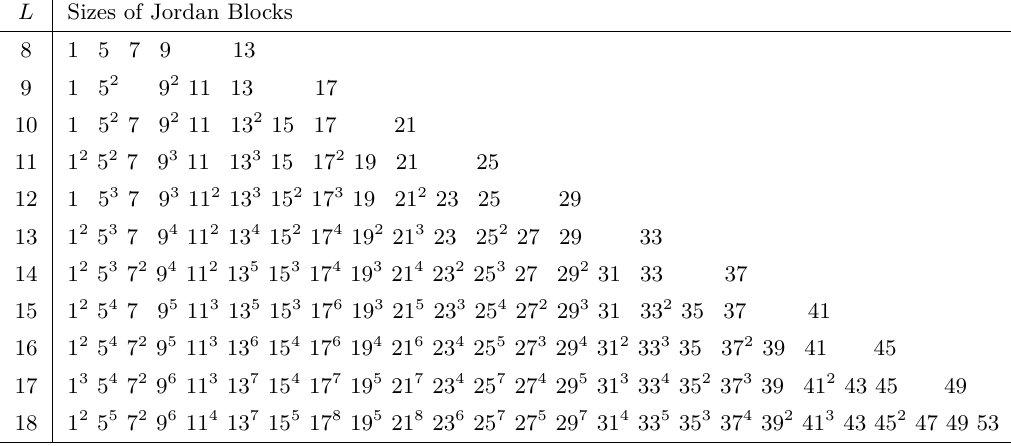
Table 3 . Structures of Jordan blocks for the sector of M = 5 , K = 1 , k = 0 (cyclic states). Exponents denote